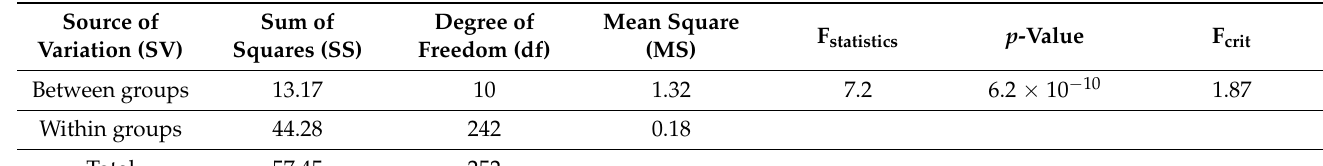
Figure 6. Mean value of taste sensations of 3 participants with highly sensitive taste buds.